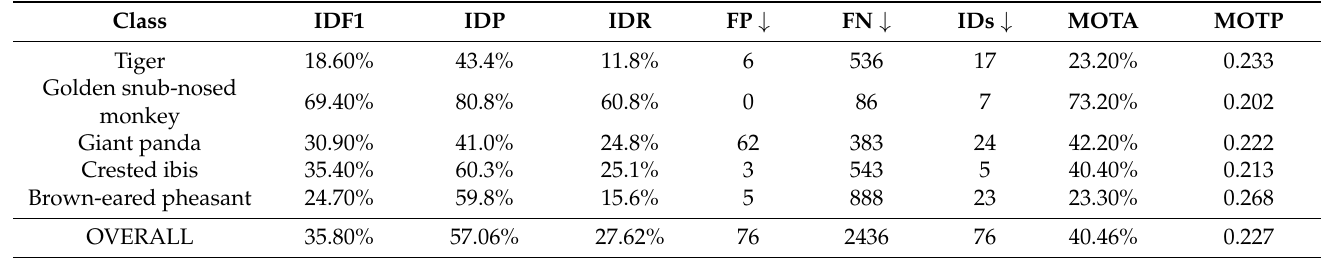
Table A5. Results of the YOLOv4 detector combined with DeepSORT tracker on the MOT-EA